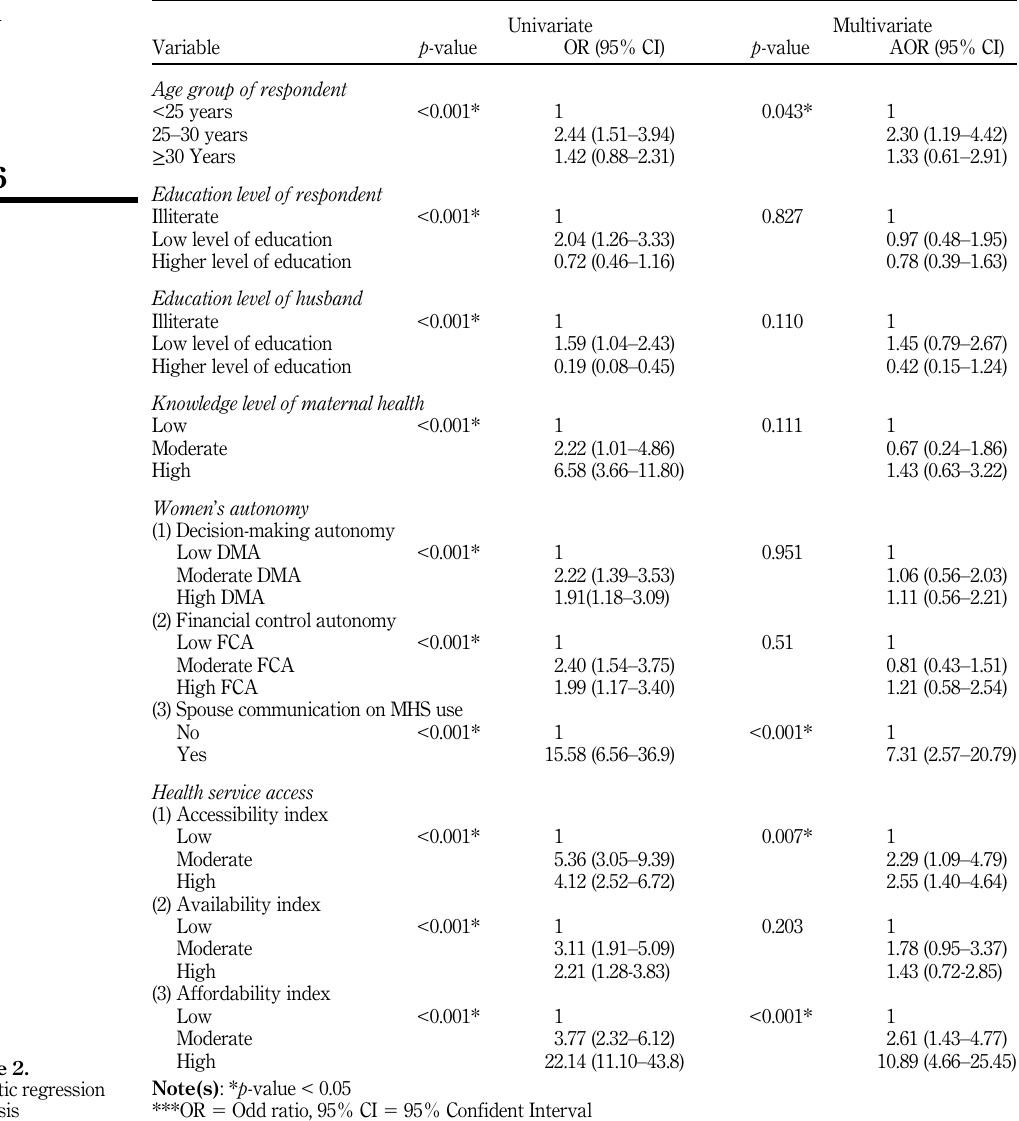
Table 2. Logistic regression